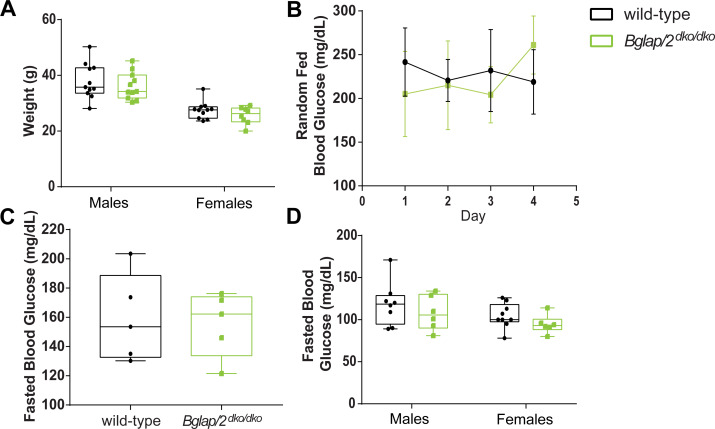
No significant evidence that whole body weight, random-fed glucose levels, or fasting glucose values differ between Bglap/2dko/dko and wild-type mice.(A) Total weight for 6-month-old Bglap/2dko/dko and wild-type males and females. Sample sizes were male wild-type (n = 11), male Bglap/2dko/dko (n = 11), female wild-type (n = 11), and female Bglap/2dko/dko (n = 8). (B) Five- to six-month-old female wild-type (n = 5) and Bglap/2dko/dko (n = 5) mice were sampled for blood glucose concentration. Samples were taken on four consecutive days, 6 h into their light cycle while having ad libitum access to food. For each mouse, at least two glucose measurements were taken each day and averaged. Means and standard deviations for each genotype are shown. (C) The animals in panel 4B were then fasted for 16 h before blood glucose was again assessed. Samples were collected on two occasions approximately one week apart. At least two glucose measurements were taken on each day and averaged. The data display the means and standard deviations for each genotype. (D) After an overnight fast and at the time of euthanasia, blood glucose was measured in 6-month-old wild-type and Bglap/2dko/dko males and females. Sample sizes are male wild-type (n = 11), male Bglap/2dko/dko (n = 11), female wild-type (n = 11), and female Bglap/2dko/dko (n = 8).